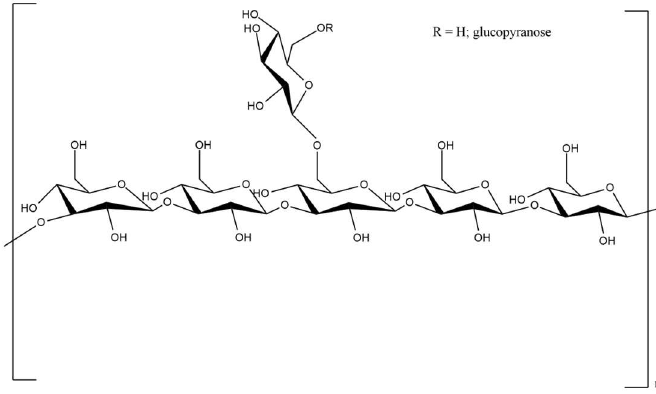
Figure 4. The chemical structure of botryosphaeran.